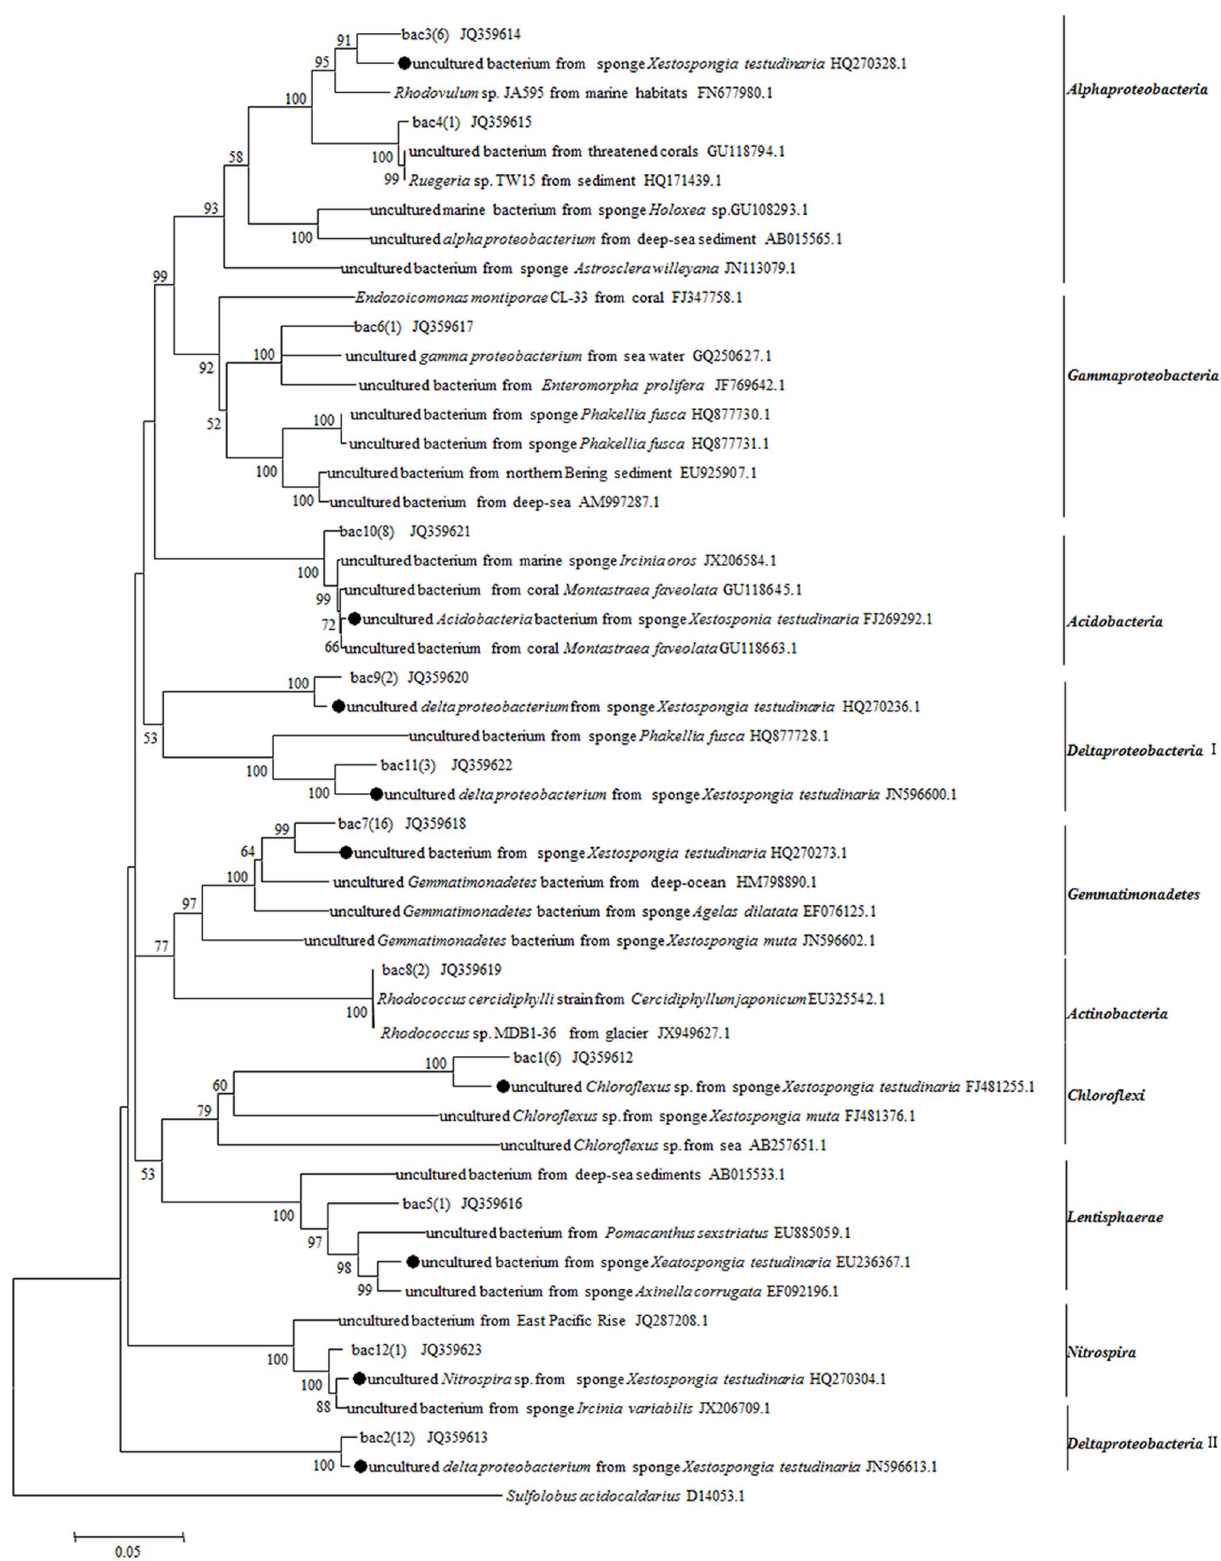
Figure 4. Unrooted phylogenetic tree based on bacterial 16S rRNA gene sequences ( ca .1,400bp) of sponge X.testudinaria using Neighbour-joining method. The scale bar represents 0.05 substitutions per nucleotide position. Bootstrap values (1,000 replicates) higher than 50% are shown. The number in brackets shows the number of sequences in each OTU.